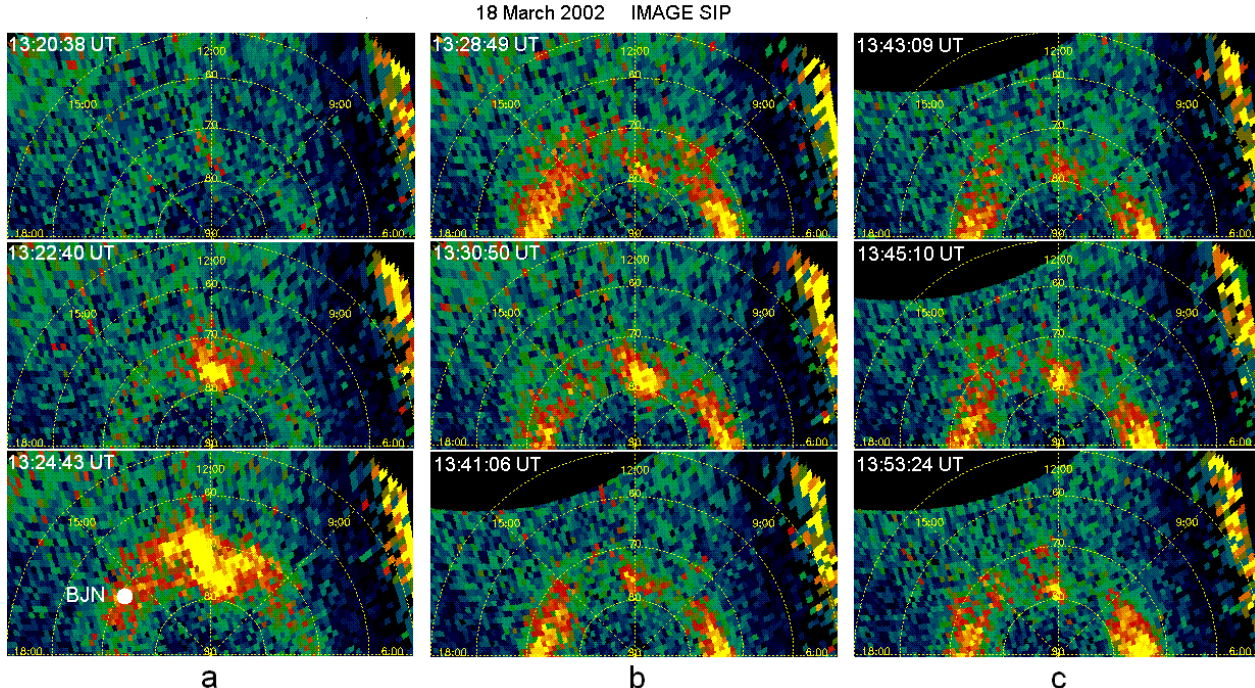
Fig. 6. Images showing three intensifications of proton auroras in the midday sector. Each of intensifications may be associated with enhancement of ULF activity at KIL (see Fig. 2b, central